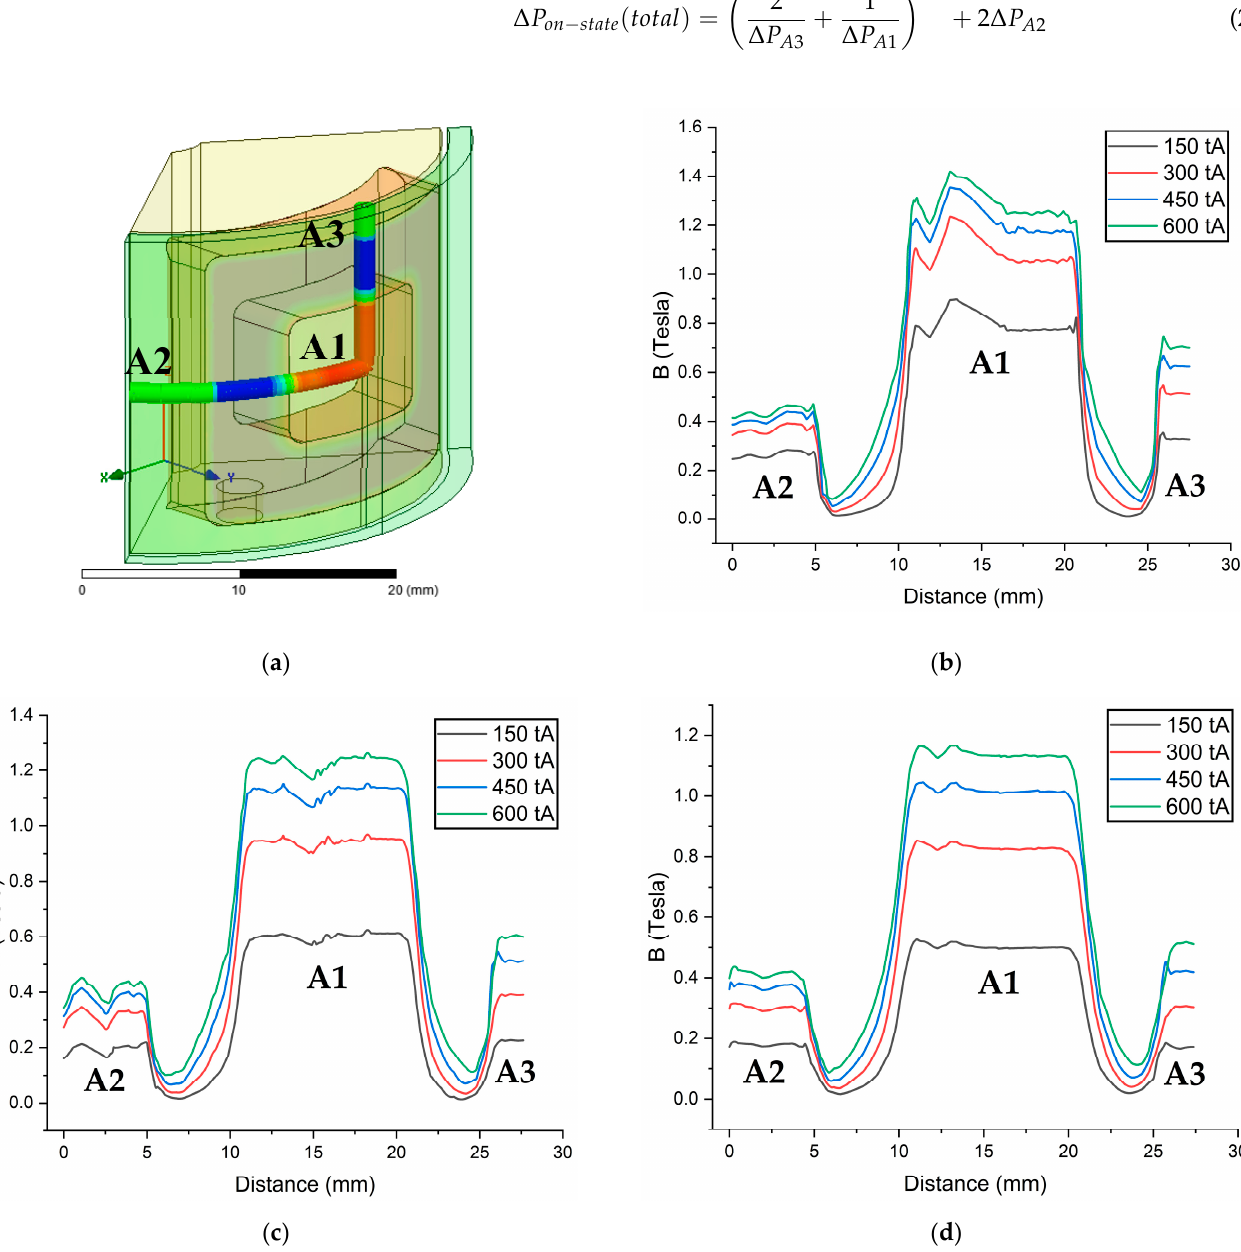
Figure 14. Simulation results of magnetic flux density in areas A1, A2, and A3: ( a ) Test path scheme; ( b ) Testing with a fluid gap of 0.5 mm; ( c ) Testing with a fluid gap of 0.75 mm; ( d ) Testing with a fluid gap of 1 mm.